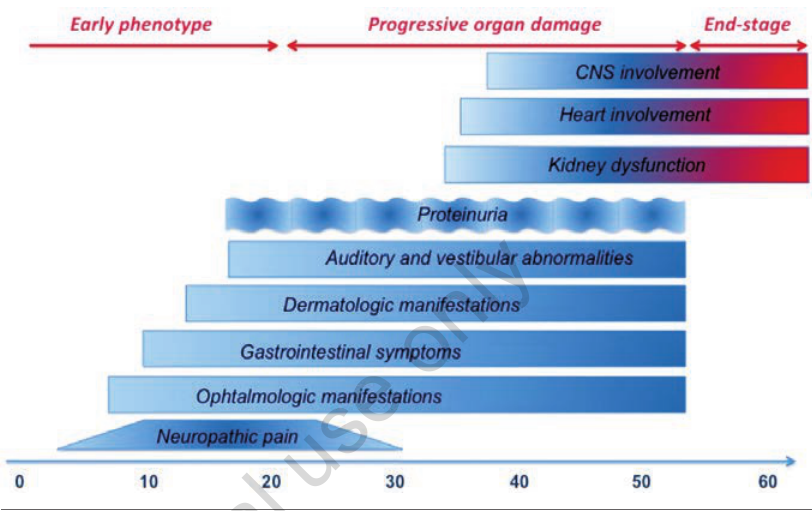
Figure 2. Symptoms onset and disease progression in classic Anderson-Fabry disease (AFD). Signs and symptoms of AFD progressively increase with age. In infancy and ado- lescence neuropathic pain, gastrointestinal manifestations and angiokeratomas are the most frequent manifestations. Proteinuria, the first sign of kidney involvement, is also present in young affected males ( Modified from Zarate and Hopkin 4 ).